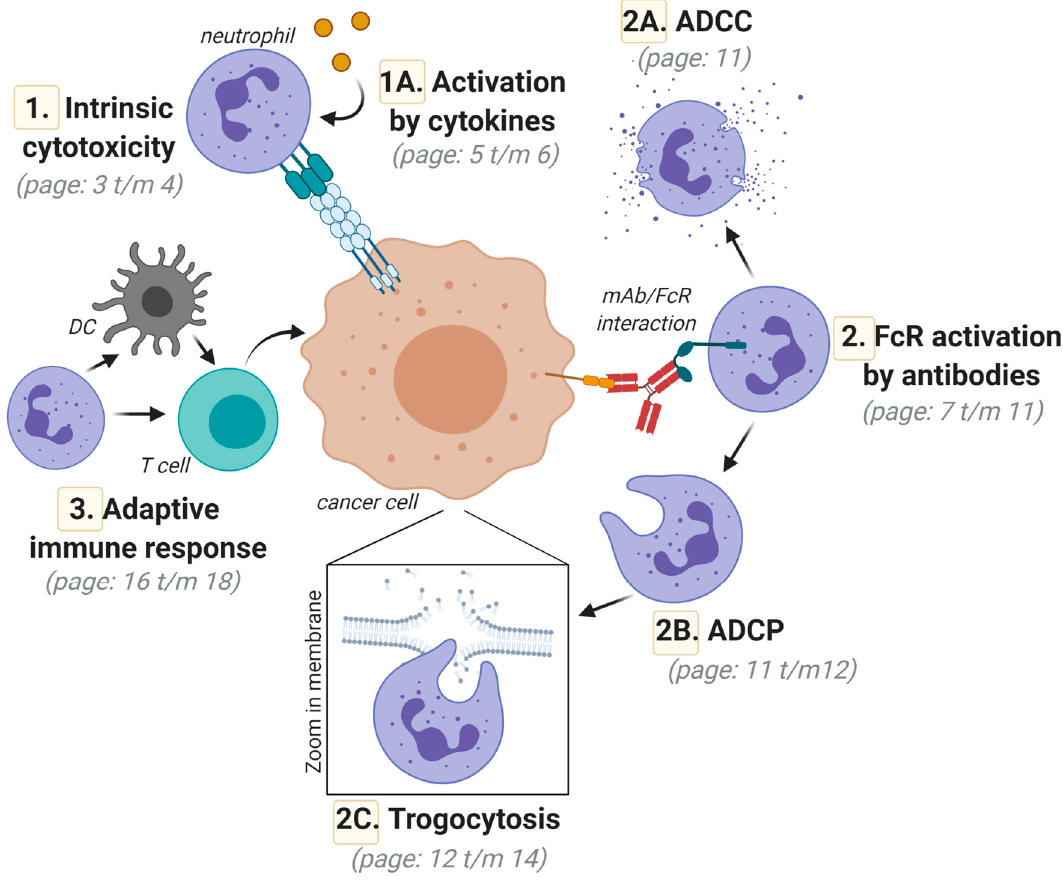
Figure 1. Overview of the review: the anticancer activity of neutrophils. 1. Intrinsic cytotoxicity via death receptor signaling that is among others 1A. stimulated by cytokines. 2. antibody-mediated Fc-receptor (FcR) activation includes: 2A. Antibody-dependent cellular cytotoxicity (ADCC), 2B. Antibody-dependent cellular phagocytosis (ADCP) and 2C. Trogocytosis. 3. Neutrophils trigger adaptive immune response by directly stimulating T cells or via the stimulation of antigen-presenting cells such as dendritic cells (DCs).